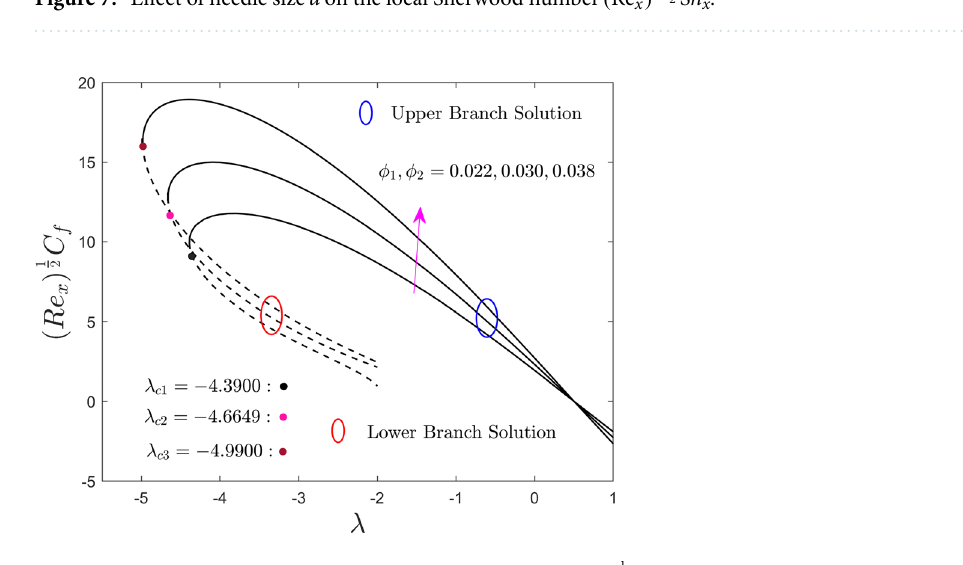
Figure 7. Effect of needle size a on the local Sherwood number ( Re x ) −